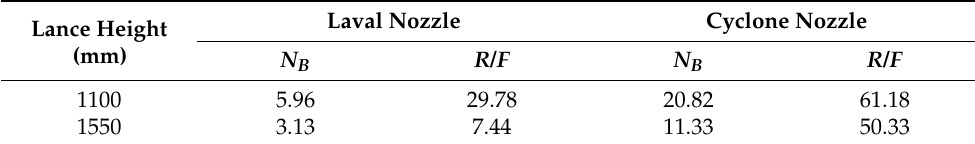
Table 3. The calculation results of N B and R / F (operation pressure 0.8 Mpa). Lance